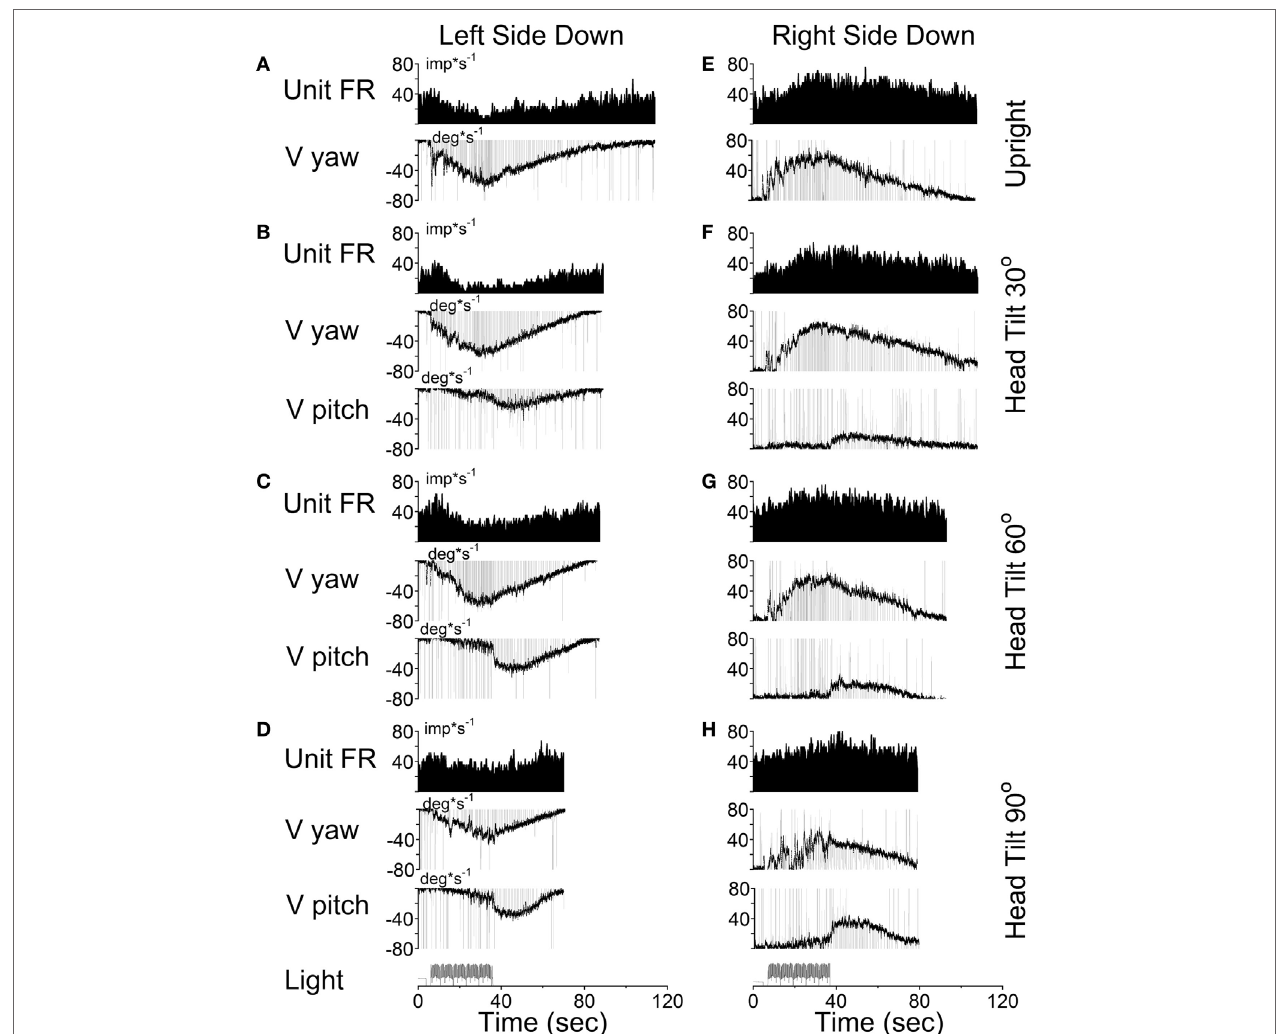
FigUre 9 | Changes in the firing rate (Unit FR) of a Type II vestibular-only neuron that receives convergent inputs from the otolith and the contralateral, lateral, and anterior canals. The neuron was tested in the left side down (a–D) and right side down (e–h) positions. For each position, the neuron was tested while upright (a,e) or while tilted 30° (B,F) , 60° (c,g) , or 90° (D,h) . The firing rate decrease in response to optokinetic nystagmus (OKN)/OKAN to the right [ (a-D) , unit FR] and increased in response to OKN/OKAN to the left [ (e–h) , unit FR]. In a tilted position, the duration of the yaw component of OKAN decreased with the tilt angle (V yaw), and there was a cross-coupled vertical component (V pitch). Changes in the firing rate of this neuron were only associated with changes in V